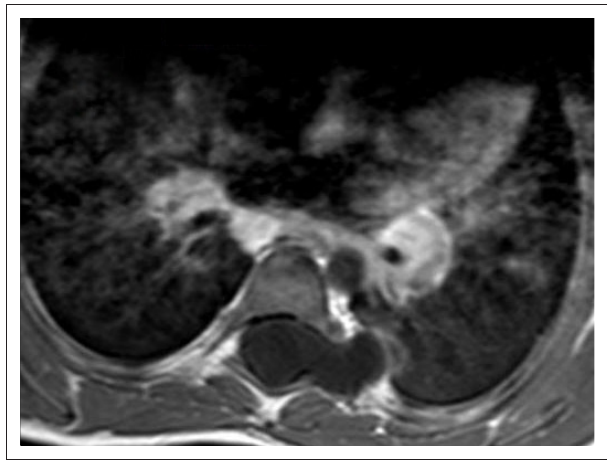
MRI, magnetic resonance imaging. FIGURE 4: Axial gadolinium-enhanced MRI image does not demonstrate significant enhancement.